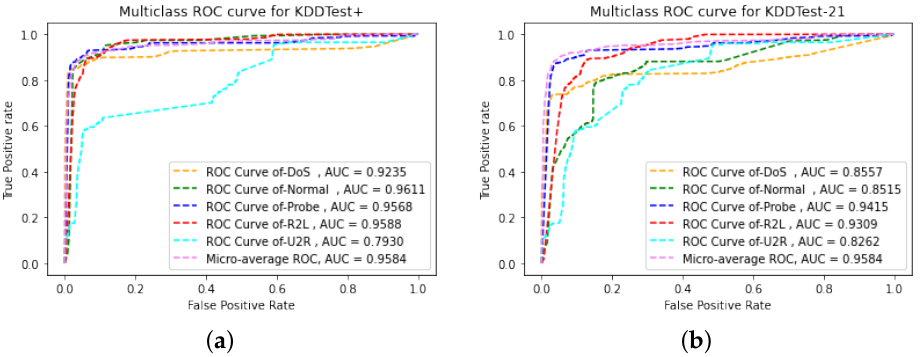
Figure 7. AUC-ROC curve on NSL-KDD test datasets. ( a ) AUC-ROC curve on the KDDTest+; ( b ) AUC-ROC curve on the KDDTest-21.